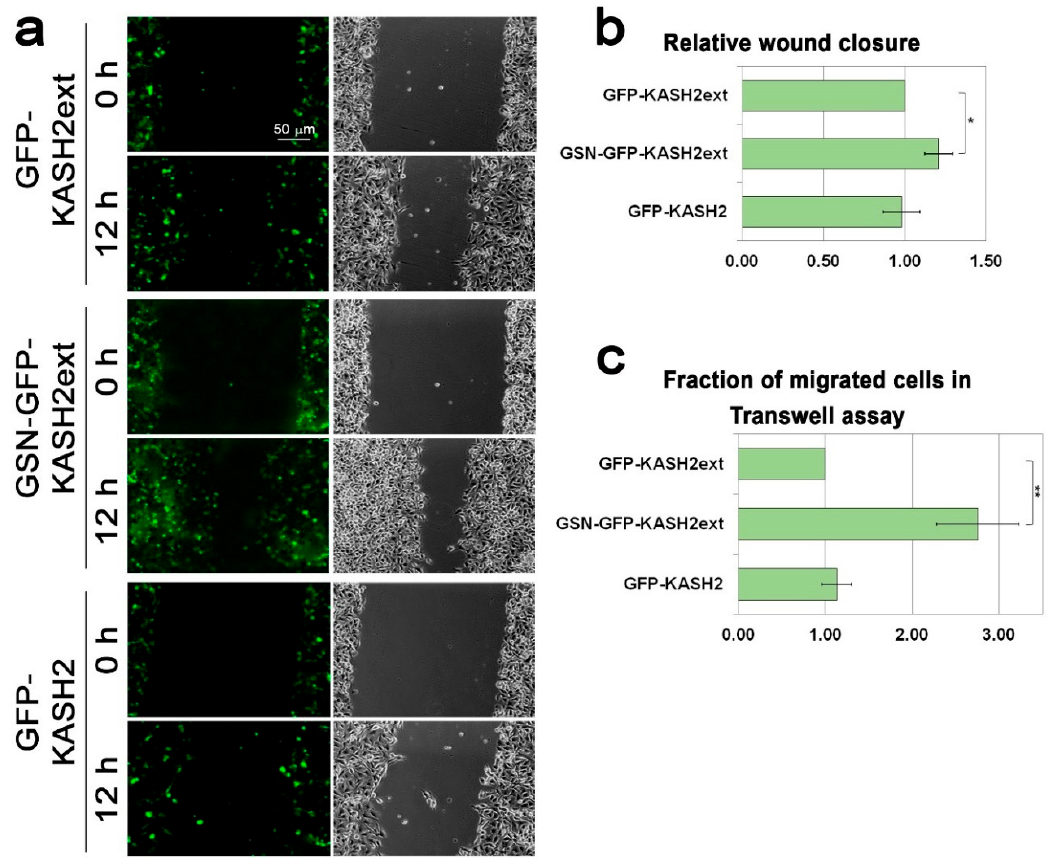
Figure 5. Interference with the perinuclear actin rim accelerates cell migration rate. ( a ) Interference with perinuclear actin filaments accelerates the migration rate of B16–F10 in the wound healing assay. The migration rate of B16–F10 cells expressing GFP-KASH2ext, GSN-GFP-KAS2ext, or GFP-KASH2 was measured by the wound healing assay. Representative GFP and phase-contrast micrographs of the same fields at time 0 (immediately after the scratch) and 12 h later. Scale bar: 50 μ m. ( b ) The area covered by the cells following 12 h of incubation was measured and set as 1 for the expressing GFP-KASH2ext cells. The graphs show the mean area covered in three independent experiments ± s.e. Statistical significance was evaluated by the Student’s t -test, * p < 0.05. ( c ) Interference with perinuclear actin filaments accelerates the migration rate of B16–F10 in the Transwell assay. The migration rate of B16–F10 cells expressing GFP-KASH2ext, GSN-GFP-KAS2ext, or GFP-KASH2 was measured by the Transwell assay. Four hours after plating the cells on top of the filters the cells were fixed, permeabilized, and stained with Hoechst reagent. In each experiment, the fraction of the transfected cells migrated to the lower side of the filter was calculated and normalized to the migration rate of GFP-KASH2ext-expressing cells. The graphs show the mean fraction of migrated cells in three independent experiments ±